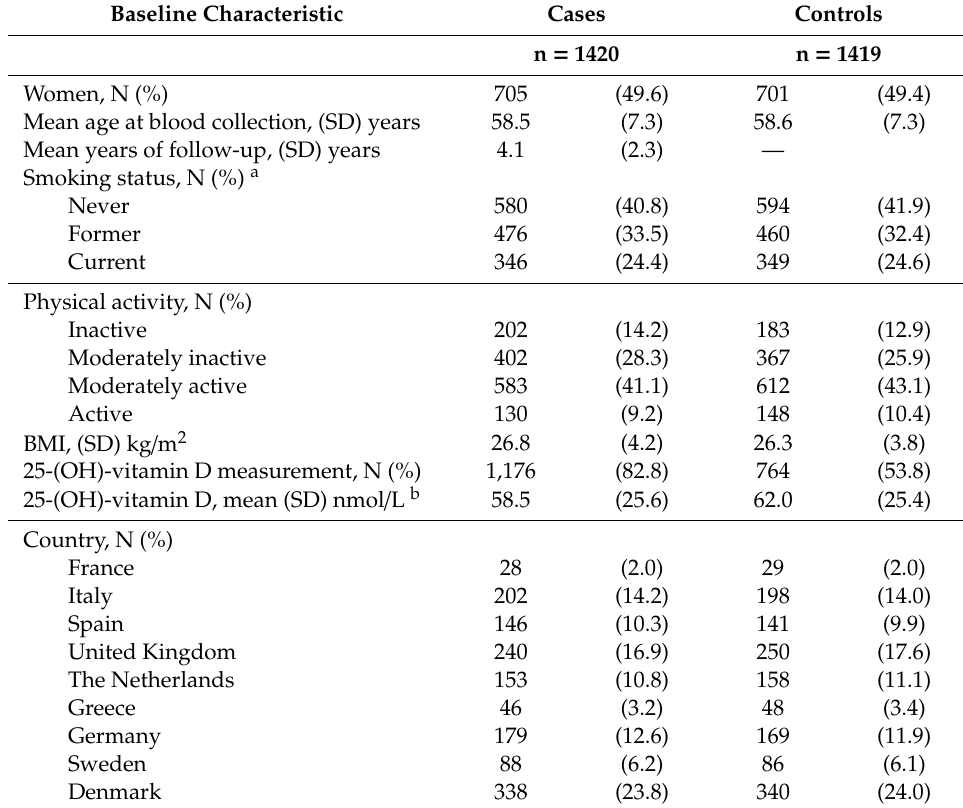
Table 1. Selected baseline characteristics of incident colorectal cancer (CRC) cases and their matched controls, the European Prospective Investigation into Cancer and Nutrition (EPIC) study,